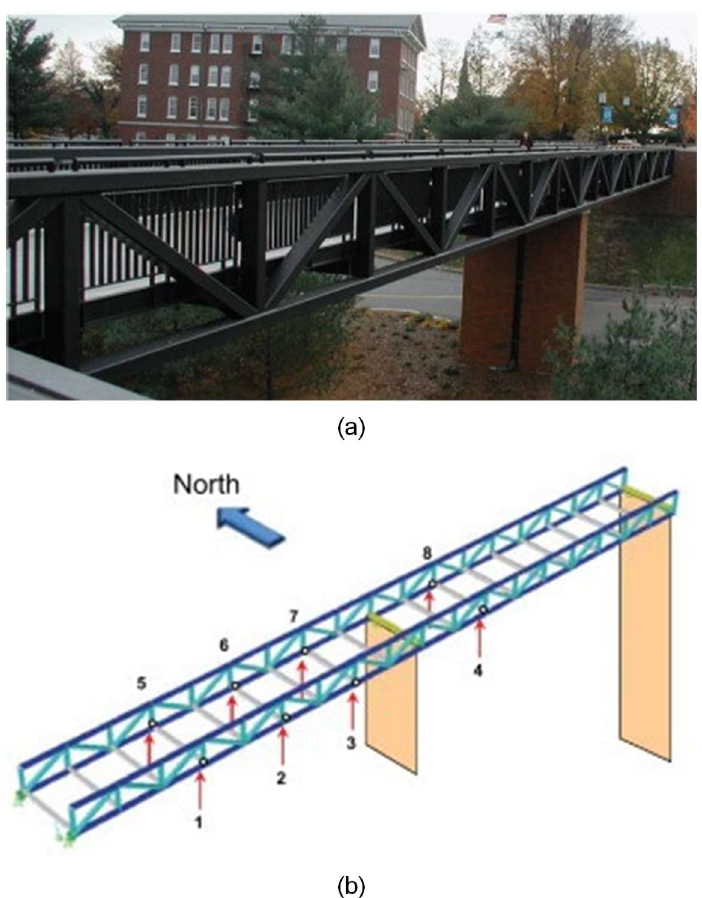
Figure 14. Dowling Hall Footbridge: ( a ) the overview; ( b ) the layout of accelerometers [43].